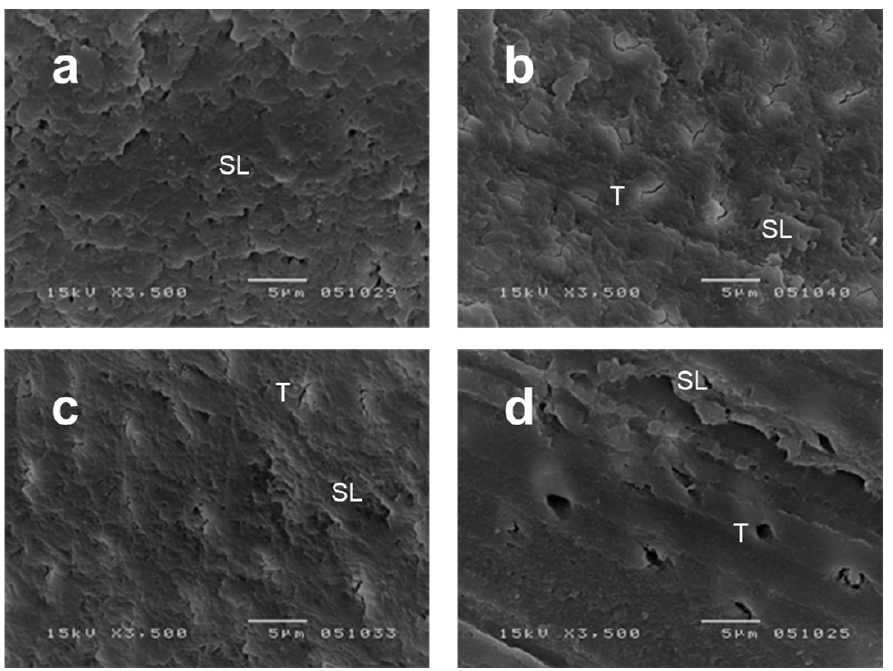
Figure 4. Representative scanning electron microscopy images (3500 × magnification) of the dentin surface before priming procedures ( a – d ), based on Otake 2010. ( a ) DS1 specimen shows a scraped surface with a rich smear layer (SL). ( b ) DS2 specimen shows a scraped surface with a rich smear layer (SL) and tubule orifice occlusion (T). ( c ) PR specimen showing a thinner smear layer (SL) and tubule orifice occlusion (T). ( d ) SD specimen showing exposed dentinal tubules (T) and a thin smear layer (SL).